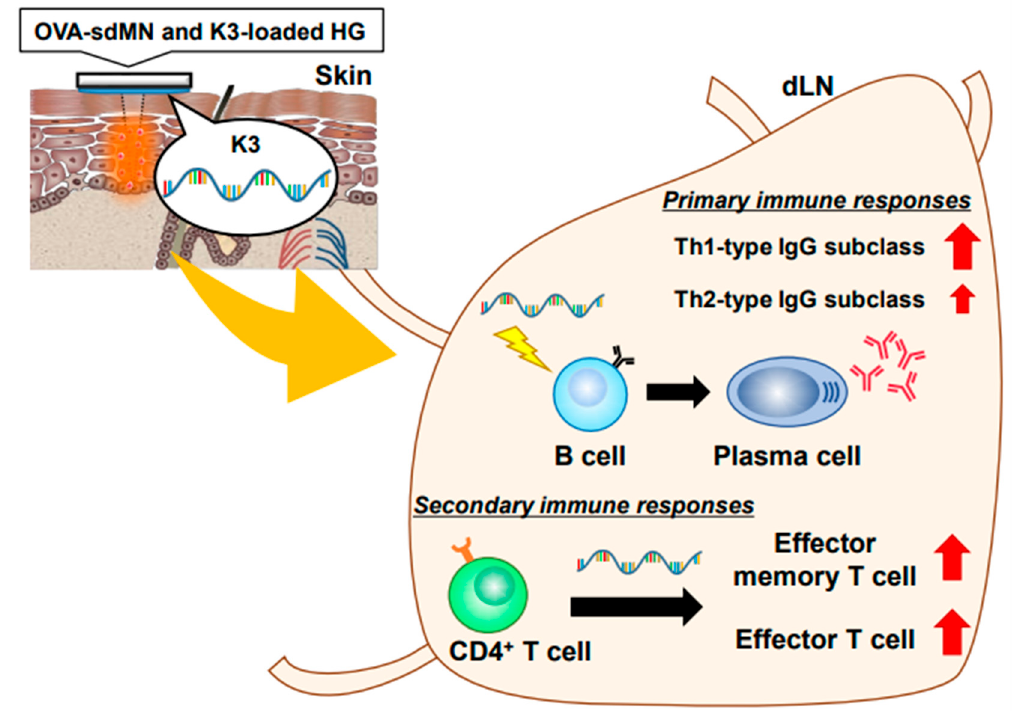
Figure 5. Mechanism of transcutaneous adjuvant efficacy by K3. Transcutaneously administered K3 acts directly on B cells and promotes plasma cell differentiation. K3 not only induced IgG1 antibodies (Th2 type IgG subclass), but also potently induced IgG2c antibodies (Th1 type IgG subclass). On performing multiple immunizations, K3 induced the differentiation of CD4 + T cells into T EM and T EFF cells. K3 also induces memory differentiation in B cells. These responses were prominent in the draining lymph nodes (dLNs) and rarely observed in the spleen.